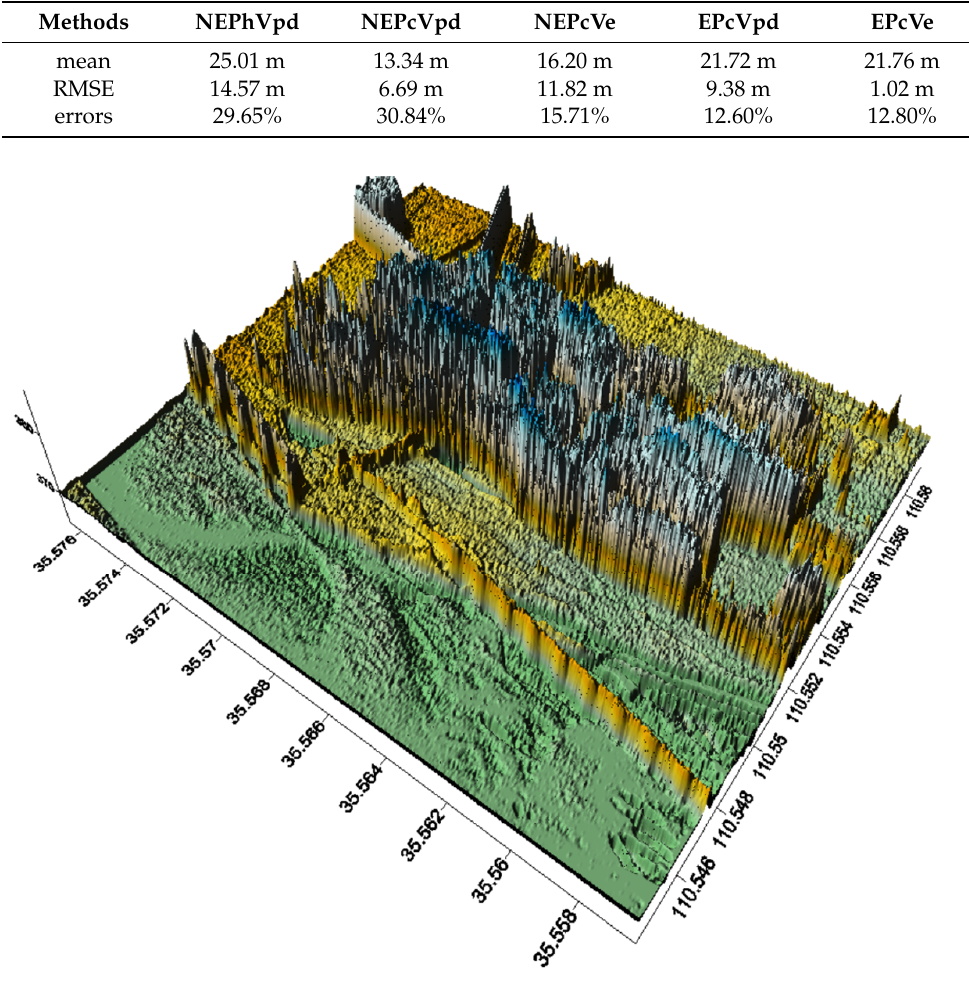
Figure 11. Three-dimensional forest height estimation result of the whole image.